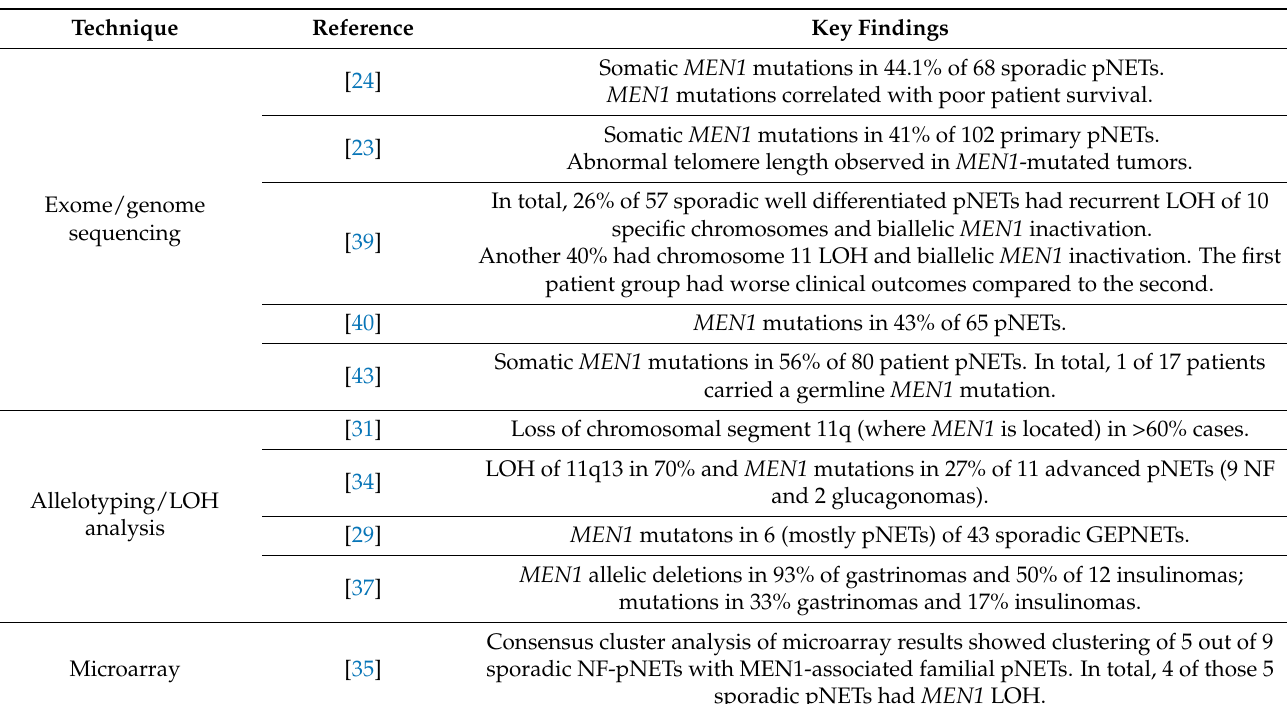
Table 1. Molecular profiling studies revealing MEN1 alterations in